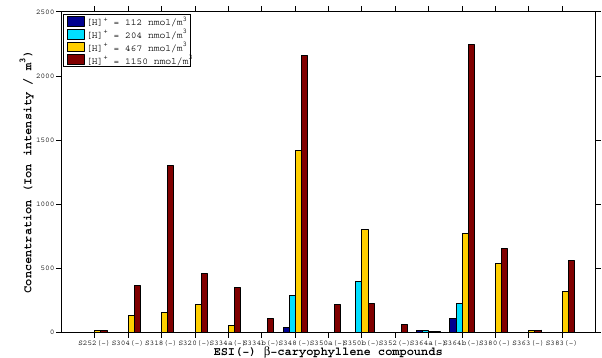
Fig. 5. Concentration of compounds detected by ESI in negative ion mode in the series of β -caryophyllene/NO x irradiation experi- ments (organosulfates and nitrated organosulfates). Chemical for- mulas and proposed chemical structures of these compounds are given in Table